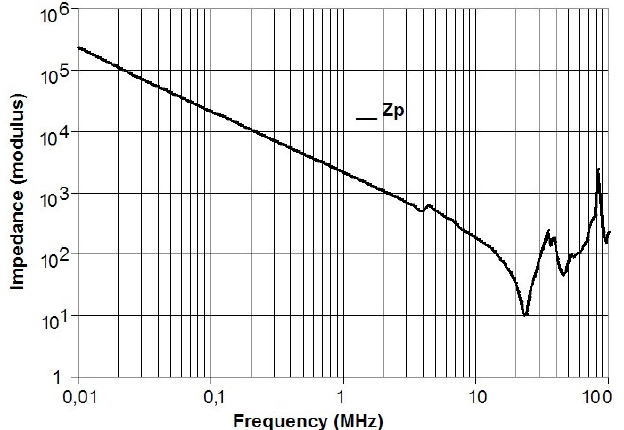
Figure 11: EMI filter